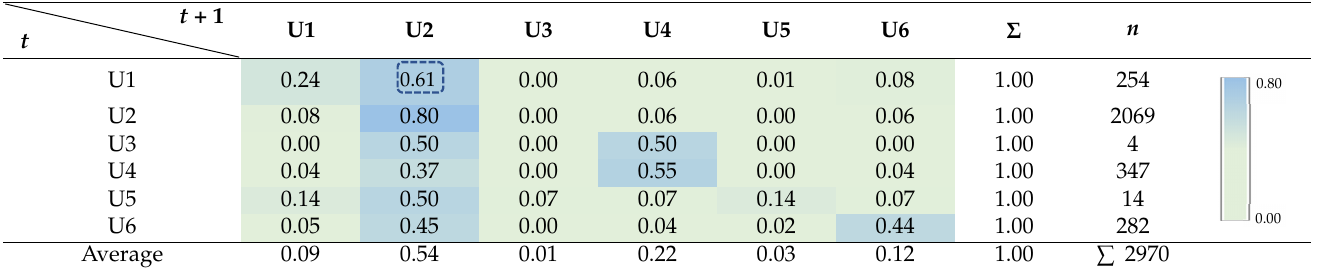
Table 5 presents the average transition probabilities for all observations for four individuals ( n = 2970 points). As expected, the probabilities of remaining in the same habitats (i.e., diagonal) were the highest at U2 (0.80), followed by U4 (0.55), and U6 (0.44). U1, the habitat with all resources (broadleaf with water), had a probability of 0.24 for remaining in the same habitat. However, the transition probability to U2 was high (0.61, dashed rectangle, Table 5). Table 5. Average TPMs between habitat states in wild boar movements (Colorbars assisting visualization of probability levels.) t + 1 U1 U2 U3 U4 U5